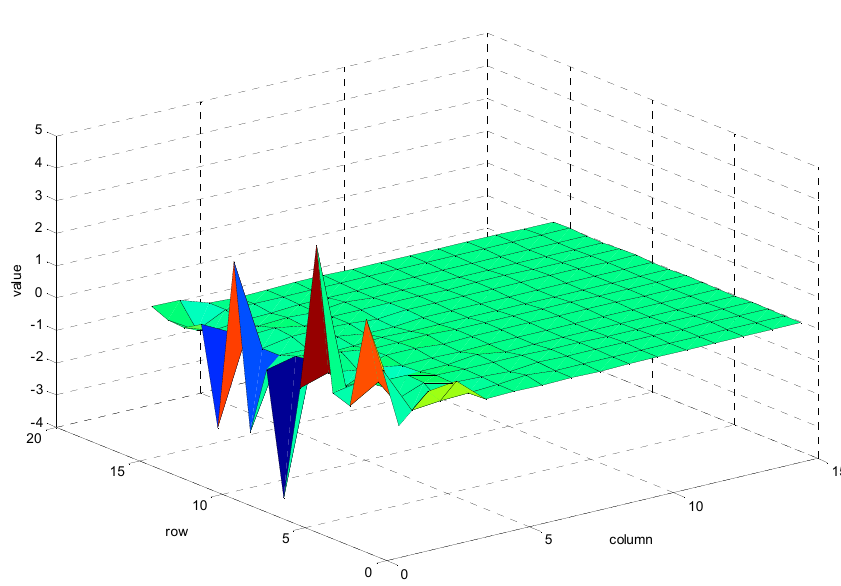
Figure 5. Example for matrix construction (“value” means the value of cells in original matrix, “column” means the column of original matrix, and “row” means the row of original matrix).